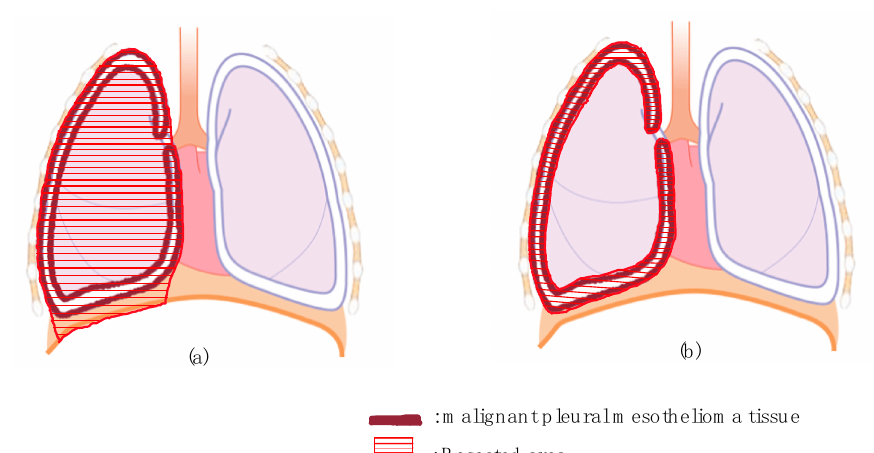
Figure 1. Surgical procedure for malignant pleural mesothelioma (MPM). ( a ) Lung-sacrificing surgery (extrapleural pneumonectomy, EPP) is shown. After the ipsilateral parietal pleura, lung, diaphragm and pericardium are removed, reconstruction of the diaphragm and pericardium is performed. ( b ) Lung-sparing surgery (pleurectomy / decortication, P / D) is shown. The ipsilateral parietal and visceral pleura are removed.